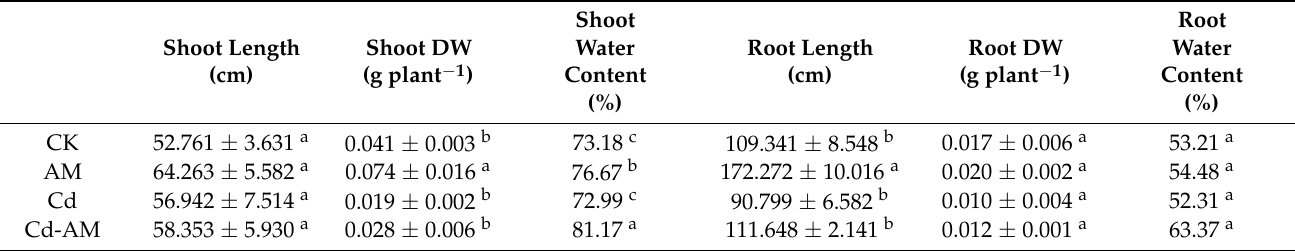
Table 1. Shoot and root length, dry weight (DW), and water content of M. truncatula under differ- ent